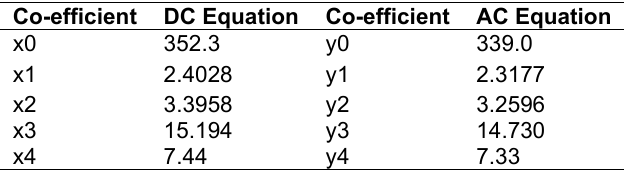
Table 3. Regression Co-efficient Terms